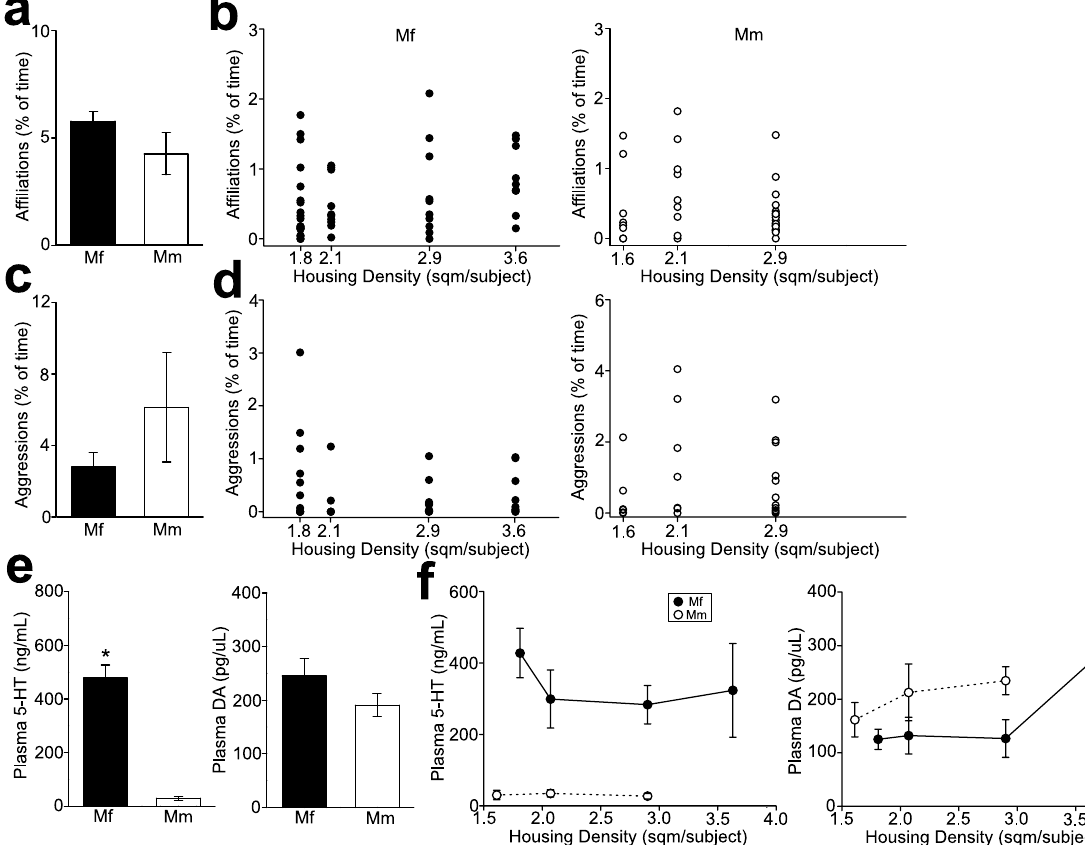
Figure 1. Social interactions and plasma monoamine concentrations in group-housed macaques. ( a ) A graph showing overall percentages of time that Japanese (Mf) and rhesus (Mm) macaques spent social affiliations. Error bars indicate mean ± s.e.m. ( b ) A graph showing the relationship between housing density and percentages of time that Japanese (left) and rhesus (right) macaques spent social affiliations on each observation day. ( c , d ) Graphs similar to ( a ) and ( b ), but showing aggressions. ( e ) A graph showing plasma 5-HT (left) and DA (right) concentrations in Japanese and rhesus macaques. * p < 0.001 for Mf and Mm. ( f ) Graphs showing the relationships between housing density and plasma 5-HT (left) and DA (right) concentrations in group-housed Japanese and rhesus